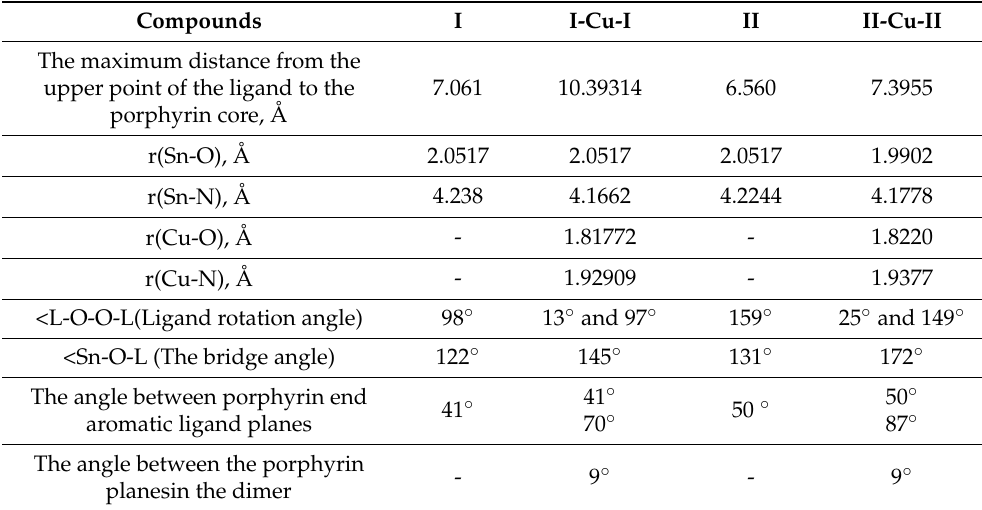
Table 1. Geometric parameters of the studied compounds obtained by quantum-chemical calculations using the Density-functional Theory DFT/CAM-B3LYP hybrid functional and 3–21 g basis. Compounds I I-Cu-I II II-Cu-II The maximum distance from the upper point of the ligand to the 7.061 10.39314 6.560 7.3955 porphyrin core, Å r(Sn-O), Å 2.0517 2.0517 2.0517 1.9902 r(Sn-N), Å 4.238 4.1662 4.2244 4.1778 r(Cu-O), Å - 1.81772 - 1.8220 r(Cu-N), Å - 1.92909 - 1.9377 <L-O-O-L(Ligand rotation angle) 98 ◦ 13 ◦ and 97 ◦ 159 ◦ 25 ◦ and 149 ◦ <Sn-O-L (The bridge angle) 122 ◦ 145 ◦ 131 ◦ 172 ◦ The angle between porphyrin end 41 ◦ 50 ◦ 41 ◦ 50 ◦ aromatic ligand planes 70 ◦ 87 ◦ The angle between the porphyrin - 9 ◦ - 9 planesin the dimer